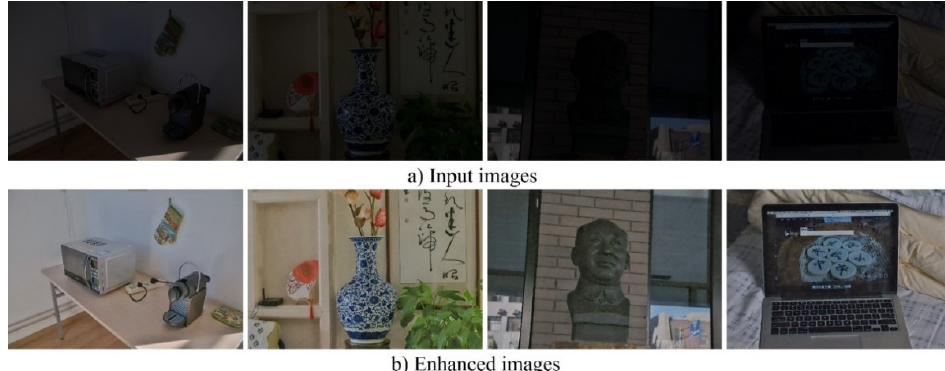
Figure 5. The results of a low-light image enhancement model using a LOL dataset [65].